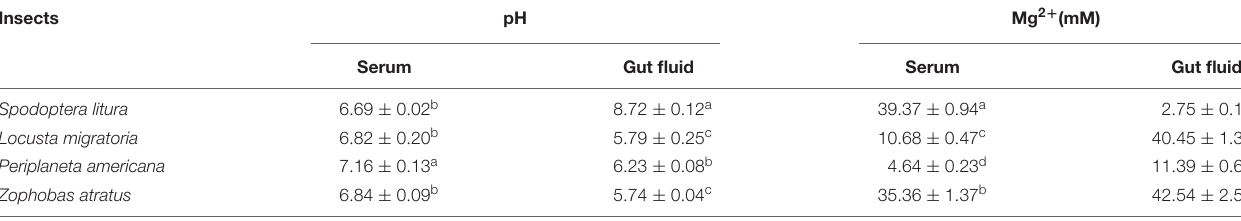
TABLE 2 | Measurements of pH values and Mg 2 + concentrations in the gut lumen and hemolymph of four insect species.